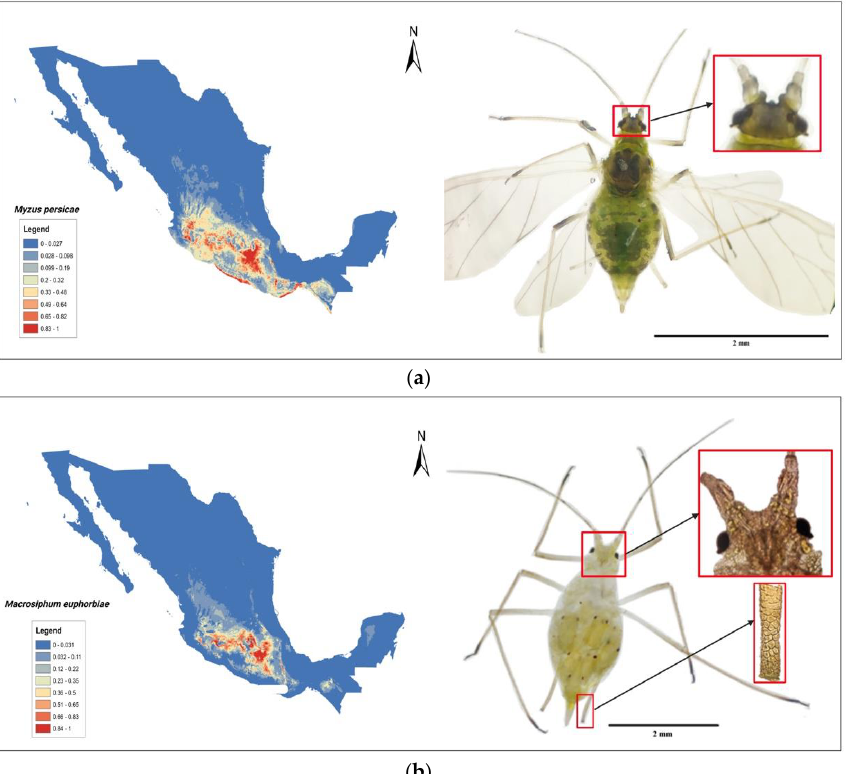
Figure 6. Geographical zones of greater adaptability according to maximum entropy modeling (Maxent); ( a ) of peach aphid, right: winged adult green peach aphid ( M. persicae ) is observed on the dorsum of the abdomen with a large dark patch and is framed by the antennal tubercles are well developed and convergent, and ( b ) of potato aphid, right: wingless female adult potato aphid ( Macrosiphum euphorbiae ) where the antennal tubercles are well developed, and the cornicle has an apical polygonal reticulation area.